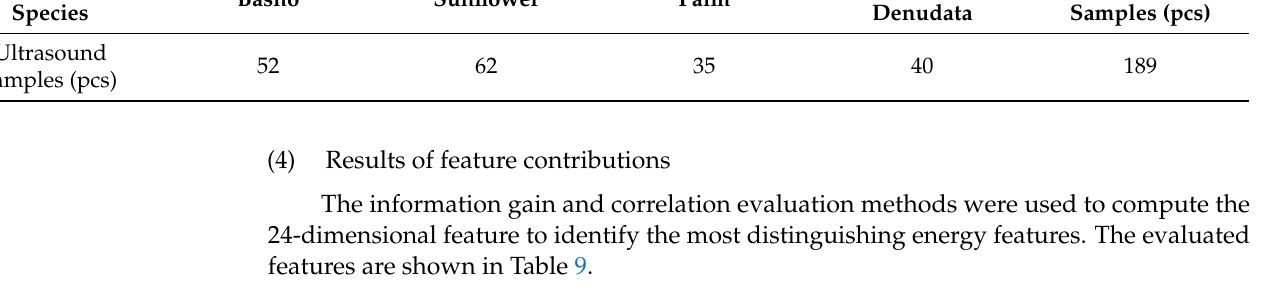
Table 9. Contribution of ultrasound features of four plant